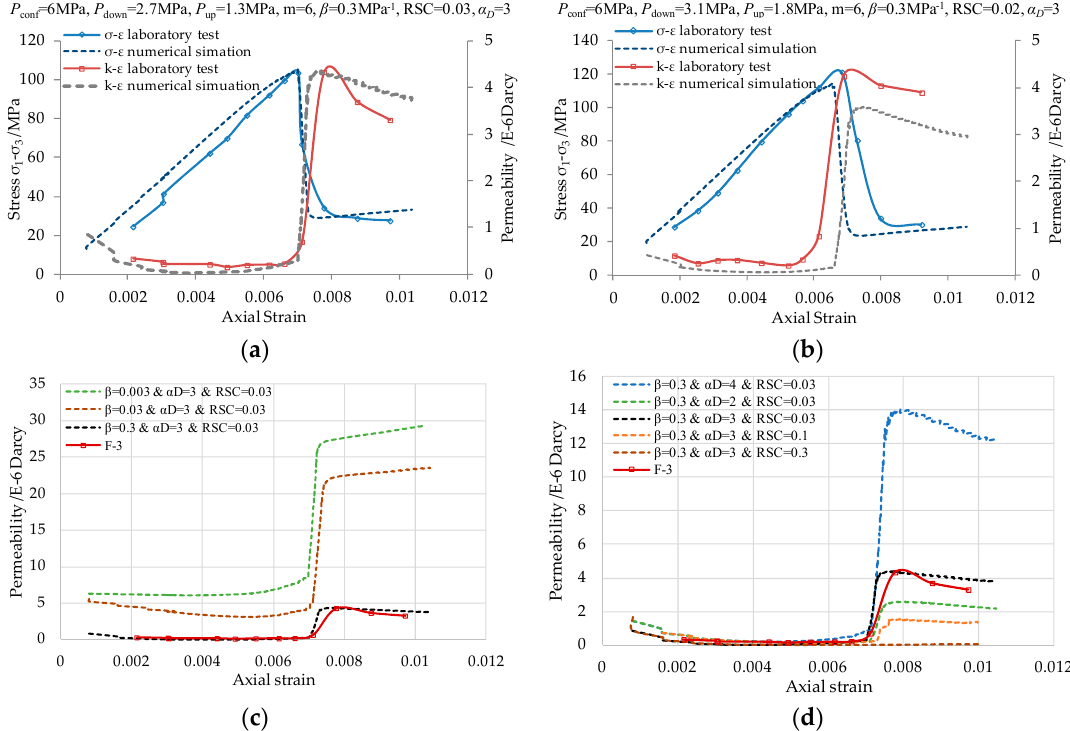
Figure 8. Permeability-strain under different variables: ( a ) Comparison results of F-3; ( b ) Comparison results of F-4; ( c ) Different β ; ( d ) Different α D and RSC.